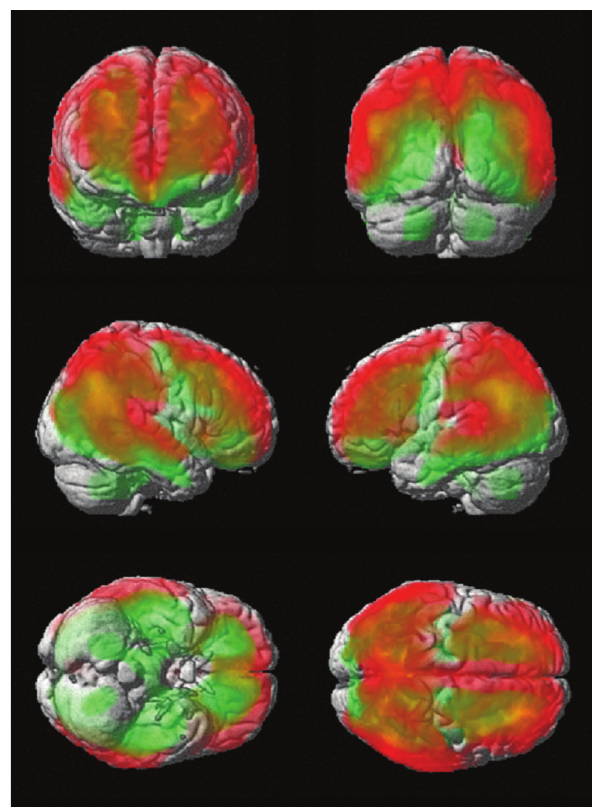
Figure 5: Comparison of [C-11]PIB SPM t -map image (red) and [F-18]FDDNP SPM t -map image (green) obtained with 10 AD patients compared with 10 healthy age-matched control subjects ( P < . 05, uncorrected, k = 100). The yellow area represents the area where the [C-11]PIB SPM t -map (red) and [F-18]FDDNP SPM t - map (green) overlapped. Adapted and reprinted with permission from Shin et al. [25] [Copyright (2010)